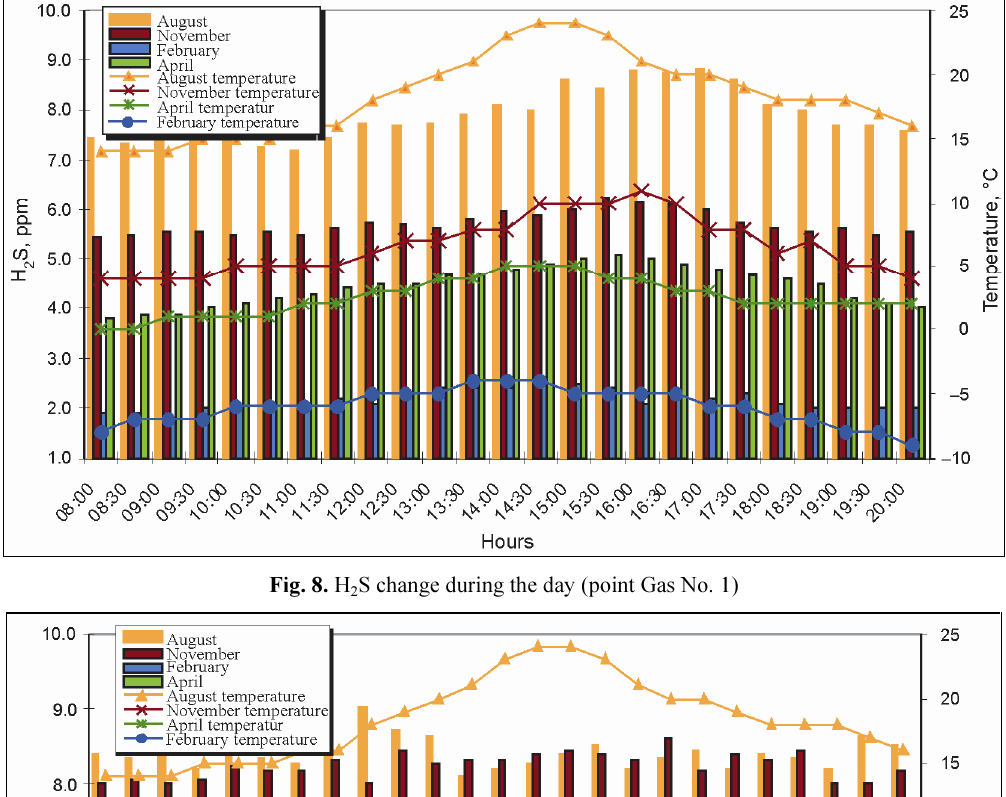
Fig. 8. H 2 S change during the day (point Gas No. 1)